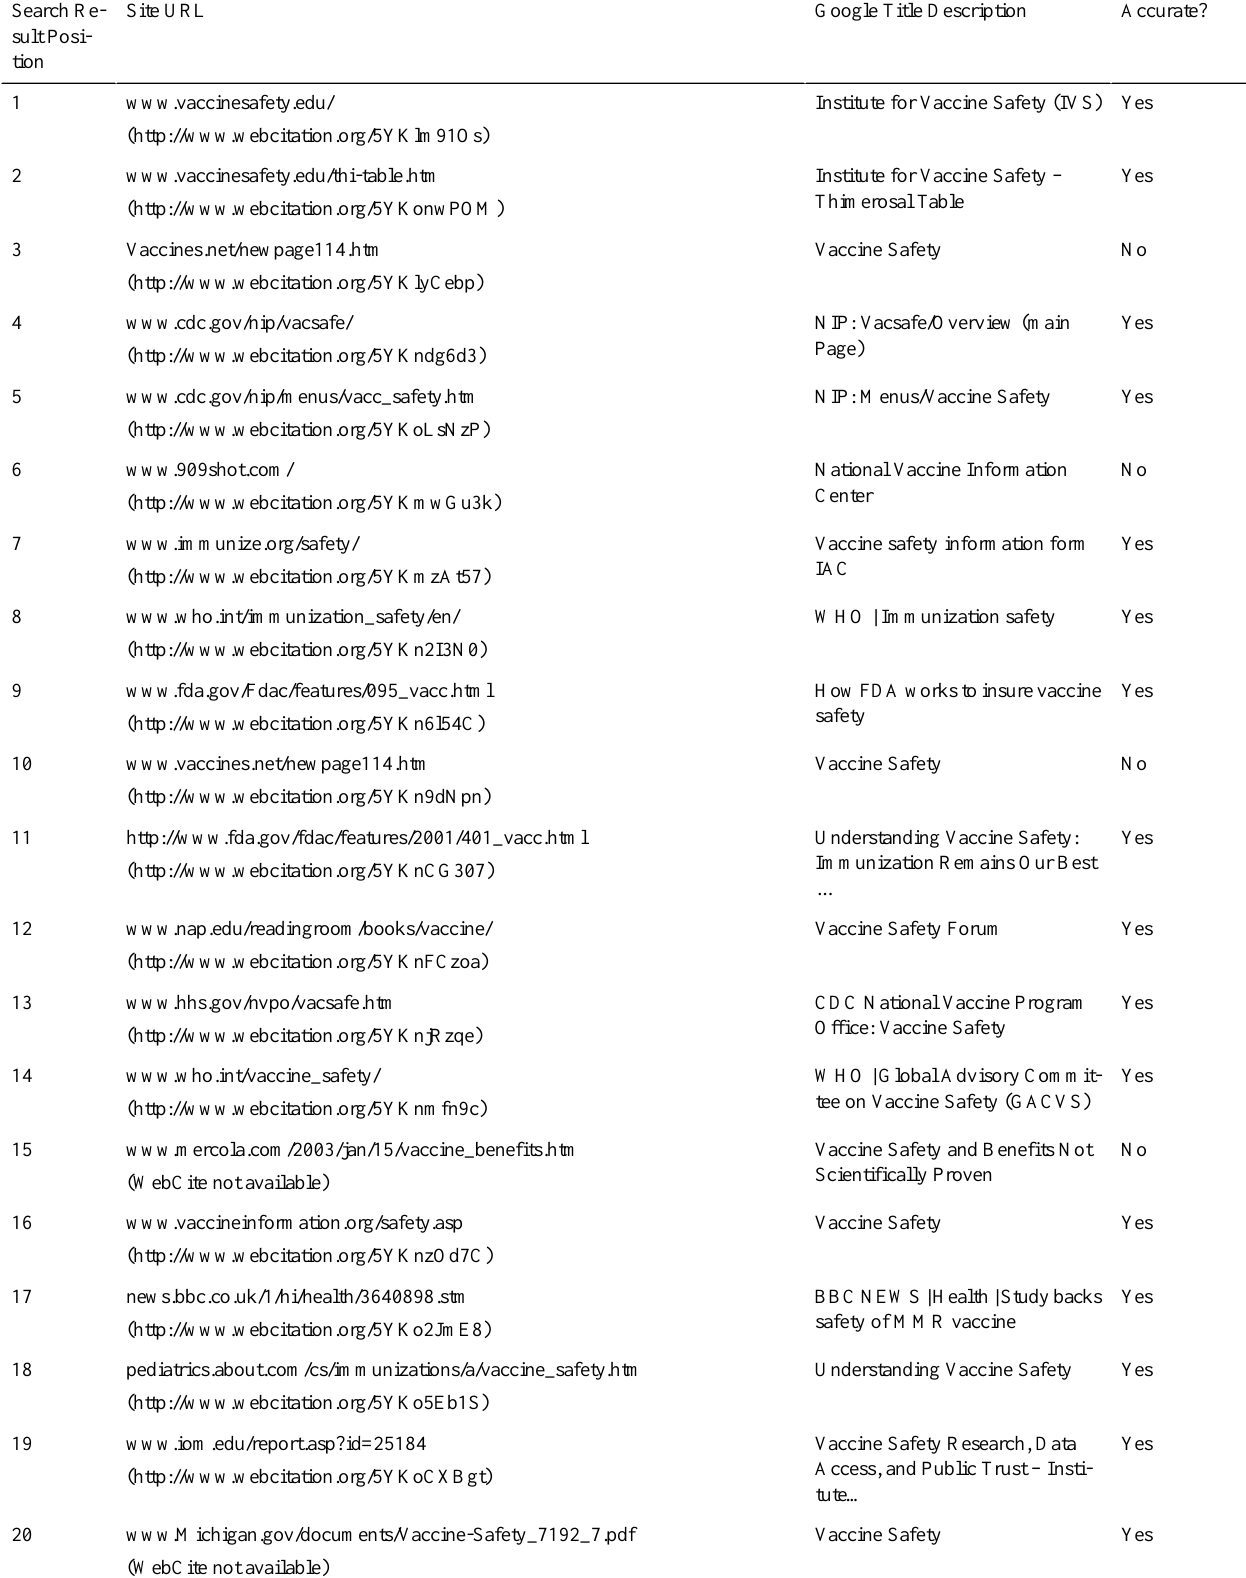
Table 2. Accuracy judgments of sites that were returned by the Google search for “vaccine